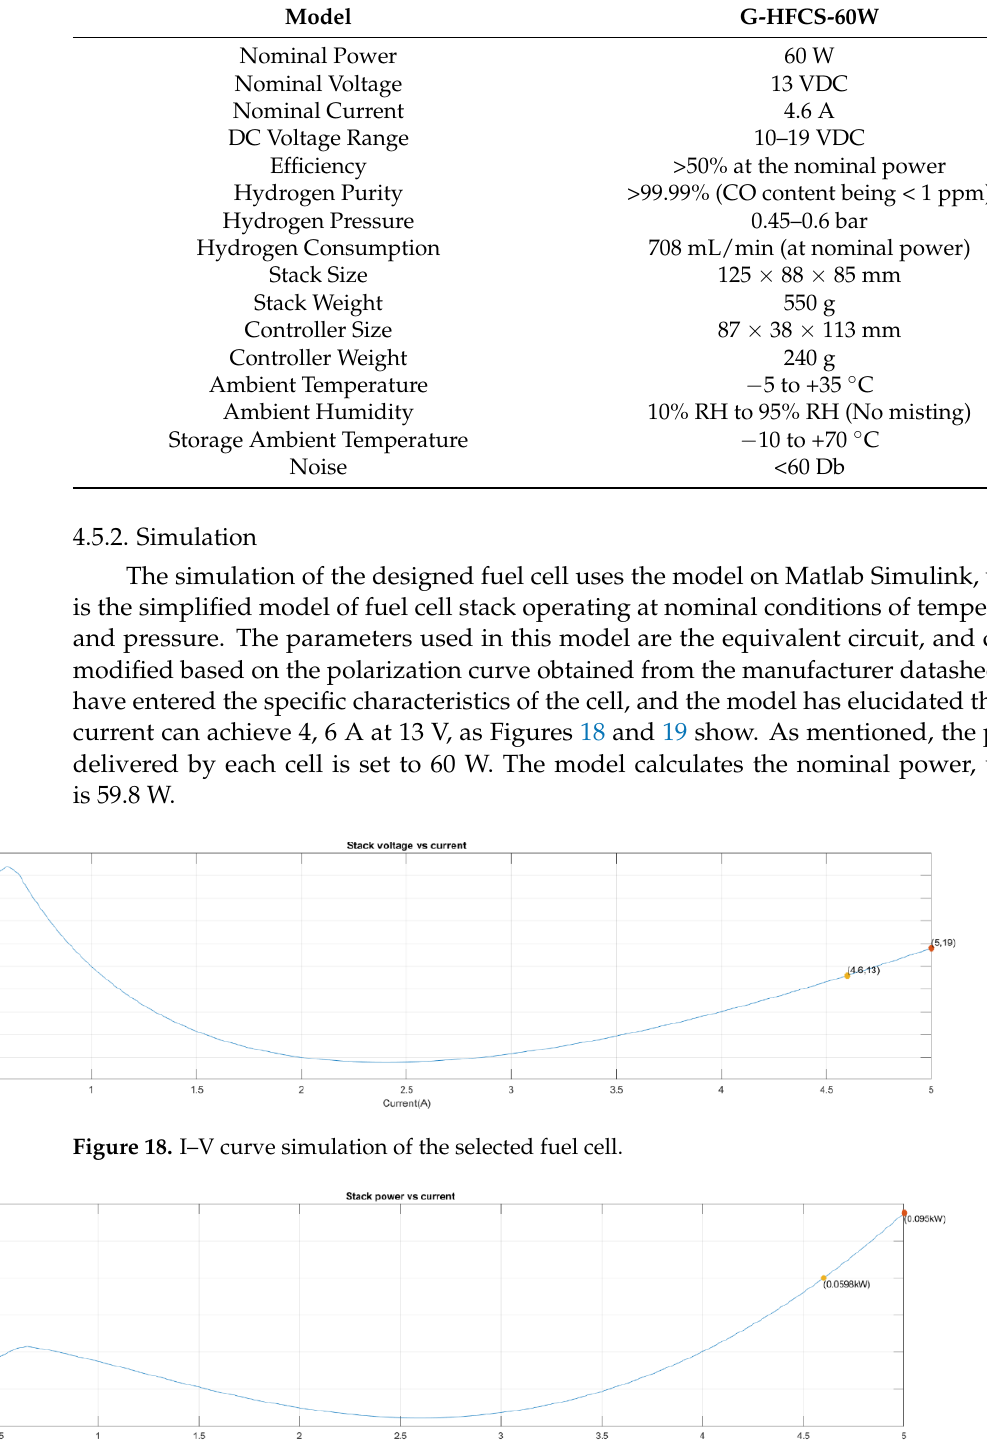
Table 7. Characteristics of the selected fuel cells.